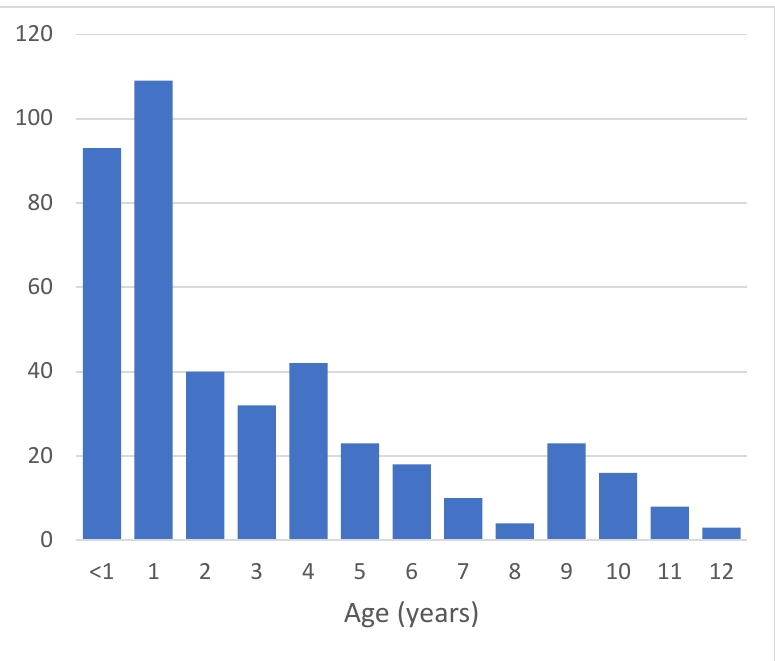
Figure 1. Age distribution of children with febrile neutropenia. Table 2. Clinical characteristics of studied patients ( n =